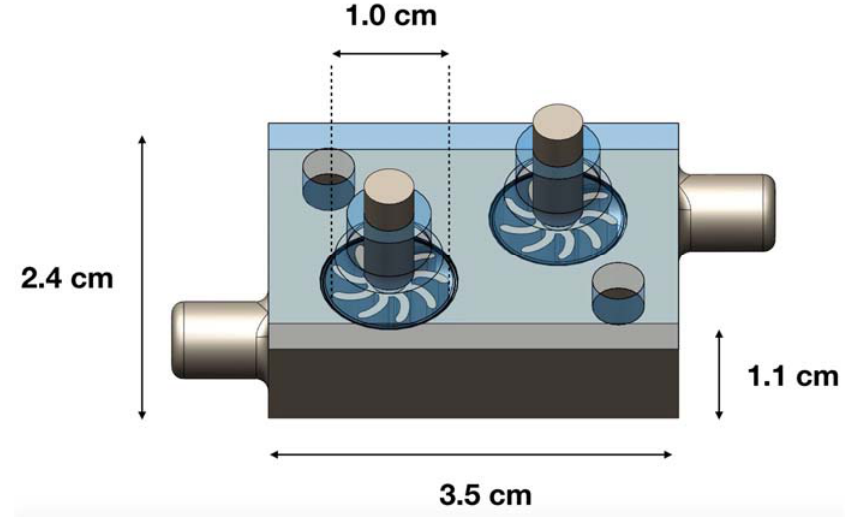
Figure 3. Radial symmetry of dual turbine enclosure allows for bi ‐ directional flow to continuously drive generators.